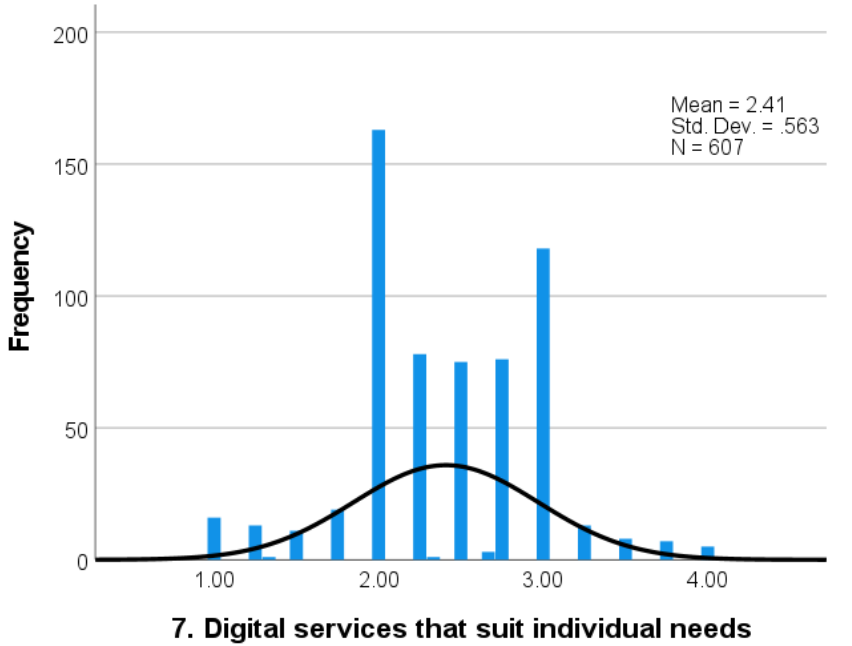
Figure A1. Distribution of eHealth Literacy Questionnaire (eHLQ) scores for the overall sample.